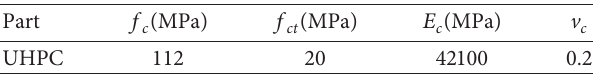
Table 4: Mechanical properties of